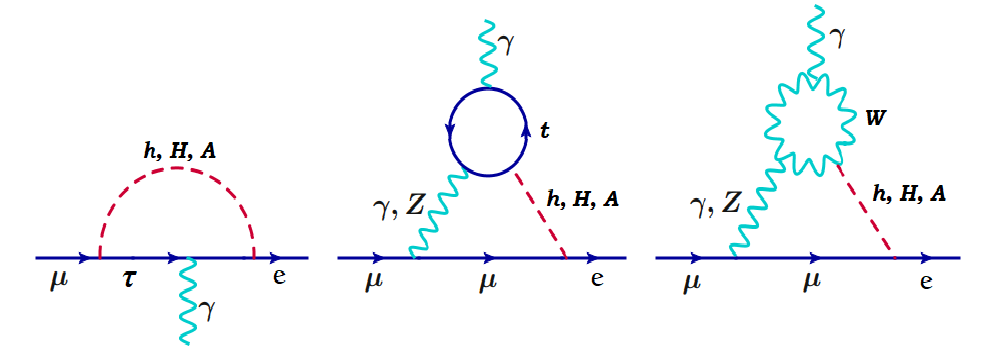
p m d m s for the CS ansatz.